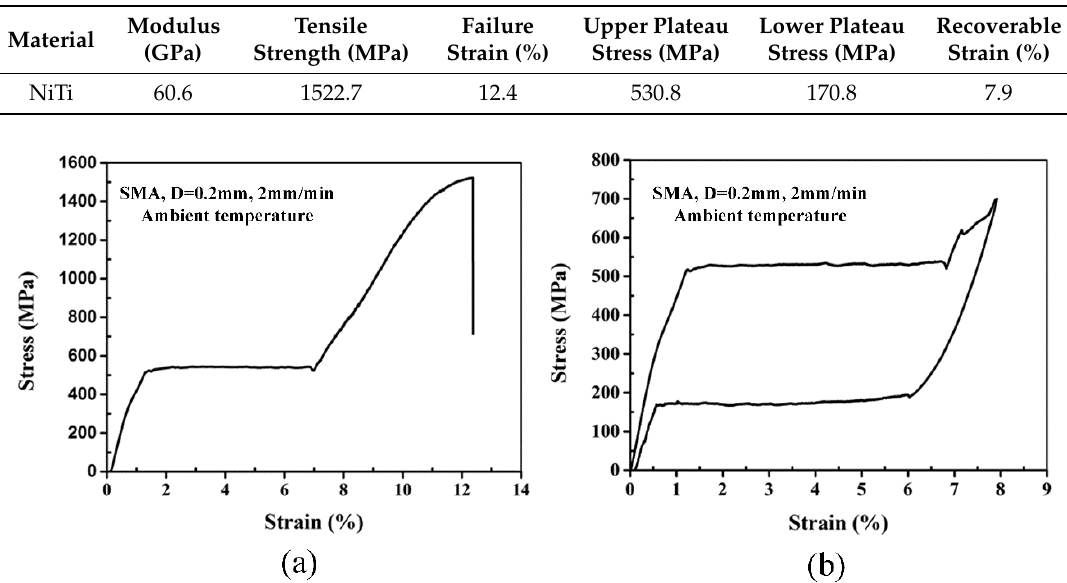
Table 2. The main mechanical characteristics of SMA wires.